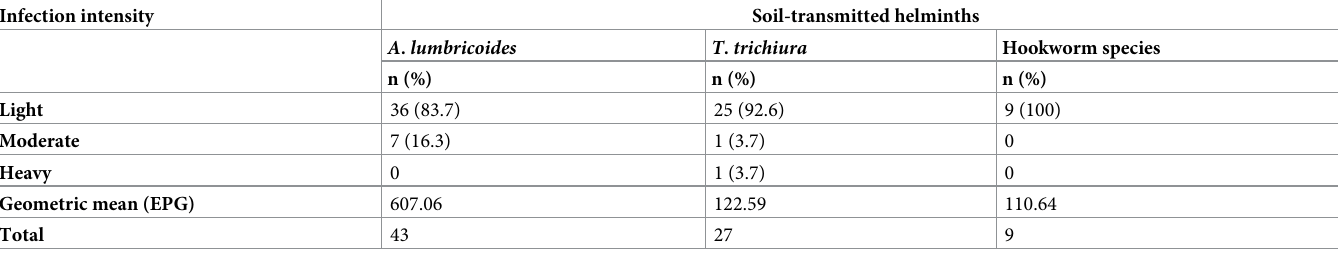
Table 2. Intensity of STH infections in the peri-urban area of Jimma town, Oromia, Ethiopia, May to July 2021 (n = 376). Infection